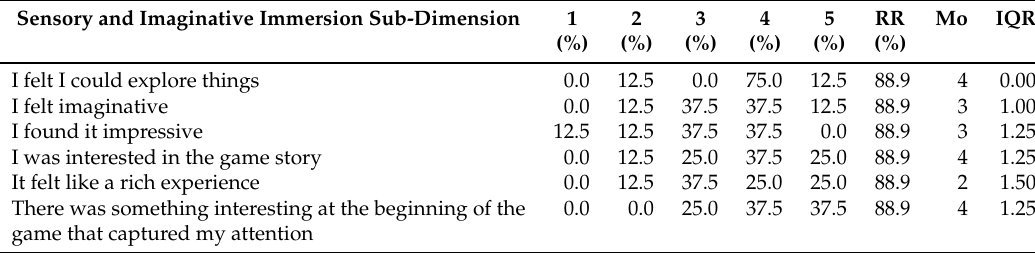
Table A7. MARISA Game feedback—Sensory and imaginative immersion